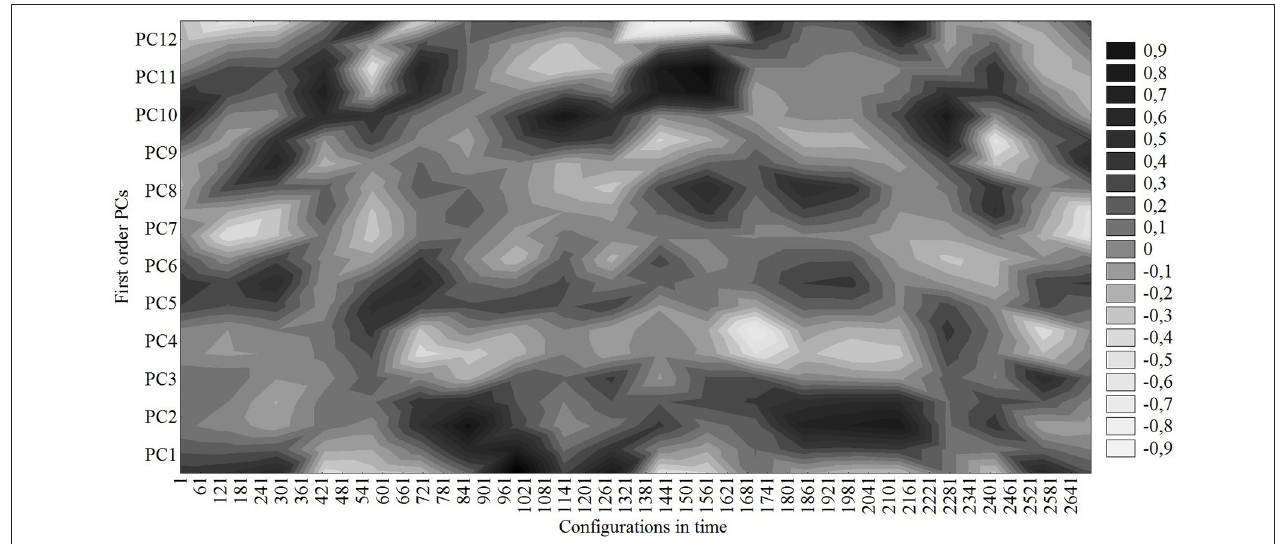
FIGURE 3 | Correlations (loadings) of time-ordered game configurations with the first-level